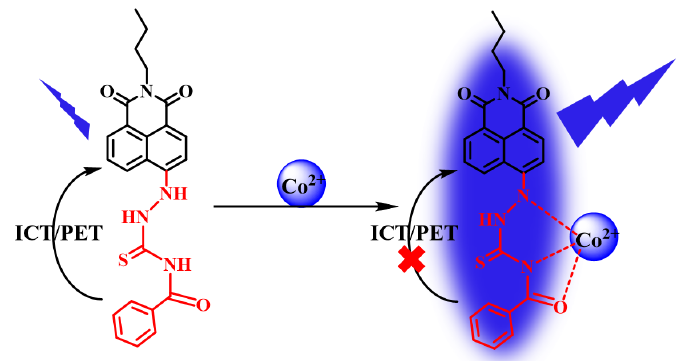
Figure 10. ( a ) Design strategy of the target L probe. ( b ) Photoinduced electron transfer (PET) in the analyte-free D–A system creates the OFF state (left); the addition of an analyte (X) blocks the PET mechanism and activates the fluorescence emission, resulting in the ON state. ( c ) Frontier molecular orbital energy diagrams of the OFF (up) and ON (down) states of an A–D System.